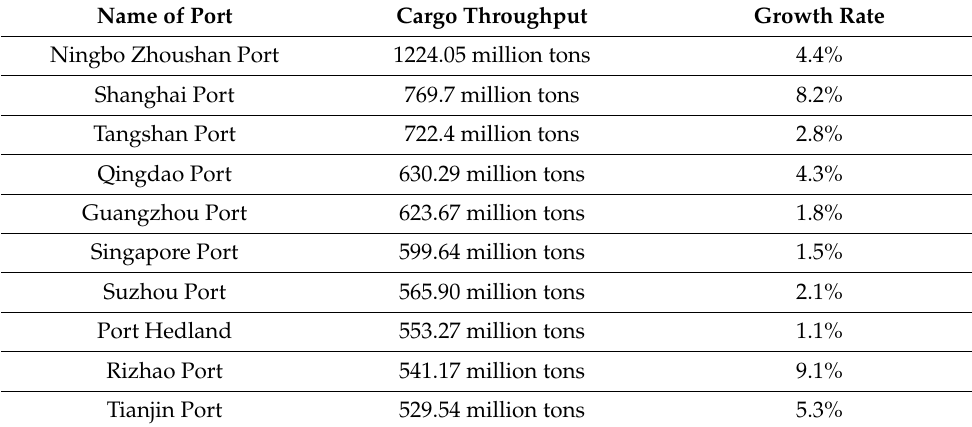
Table 1. Top 10 Ports in the World in 2022 (Based on Cargo